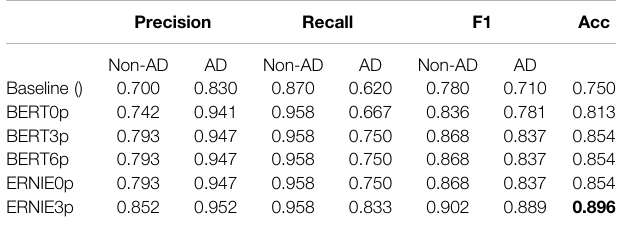
TABLE 4 | Evaluation results: Best accuracy (acc) with ERNIE and three pauses (3p). Pauses are helpful: three pauses (3p) and six pauses (6p) have better accuracy than no pauses